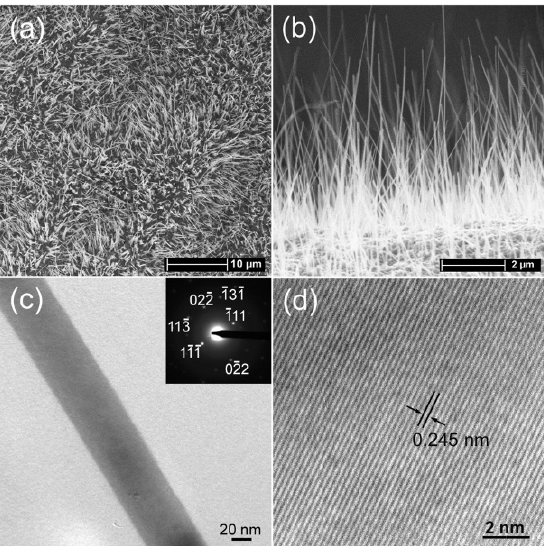
Figure 1. SEMimagesofCu 2 Onanowires: topview(a)andsideview (b). (c) TEM image of a single nanowire. The inset is the corresponding SAED pattern. (d) HRTEM image of Cu 2 O nanowire. The nanowire consists of well-defined contin- uous (111) planes (d = 0.245 nm), which pack parallely along the direction of nanowire growth direction.